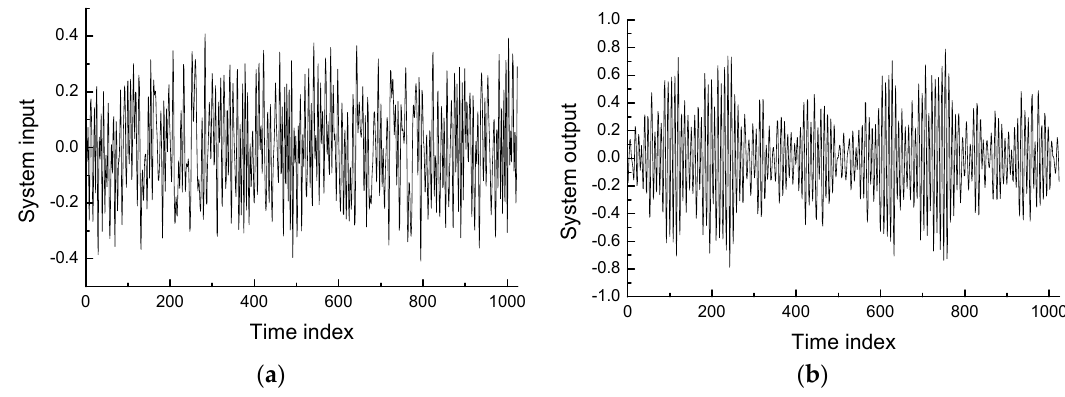
Figure 2. Flexible robot arm attributes. ( a ) System input; ( b ) system output.